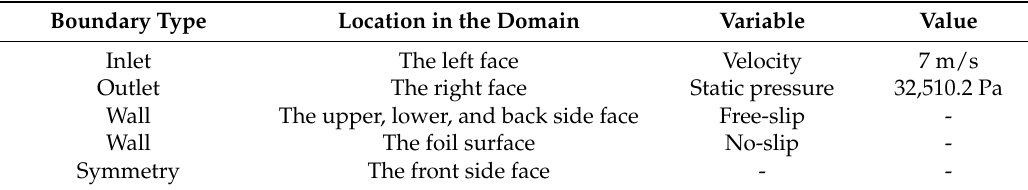
Table 3. The list of boundary conditions.